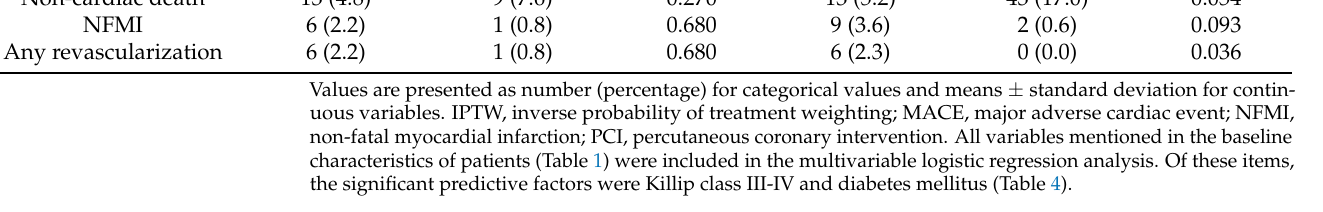
Table 4. Multivariable analysis for predictors of